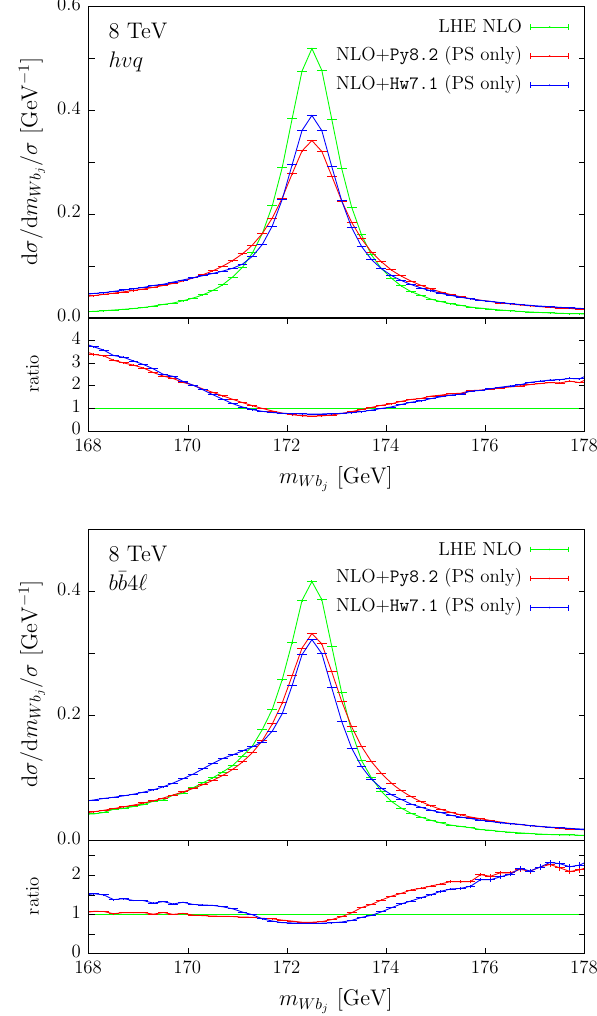
Fig. 5 d σ/ dm Wb distribution obtained with h v q (upper pane) and j b ¯ b 4 (cid:4) (lower pane) at the NLO LHE level (green), and at NLO+shower (in red Pythia8.2 and in blue Herwig7.1 ), normalized to 1 in the displayed range. In the bottom panel the ratio with the NLO LHE is